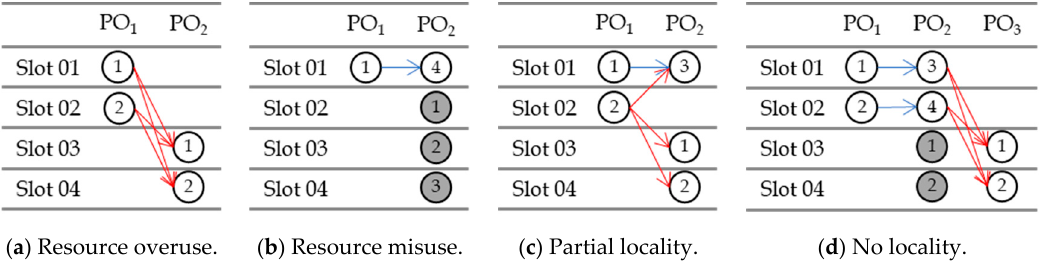
Figure 3. Examples of problems that even job scheduler encounters in DSPE applications with locality-aware stream partitioning (LSP).